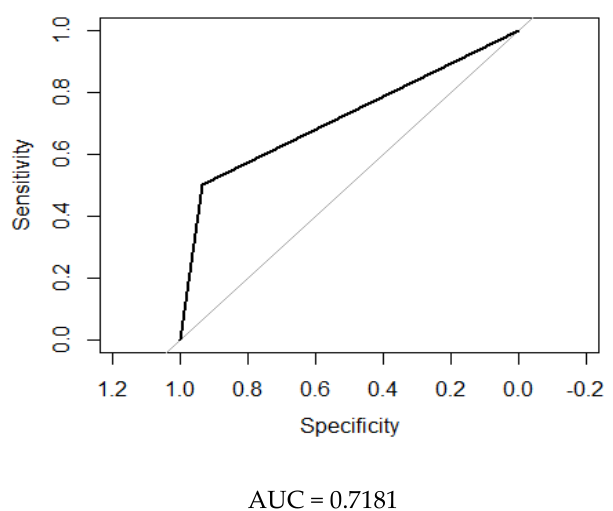
Figure 3. Receiver operating characteristic (ROC) curve of DEC versus electromyography (EMG) as the gold standard in the population with prediabetes.